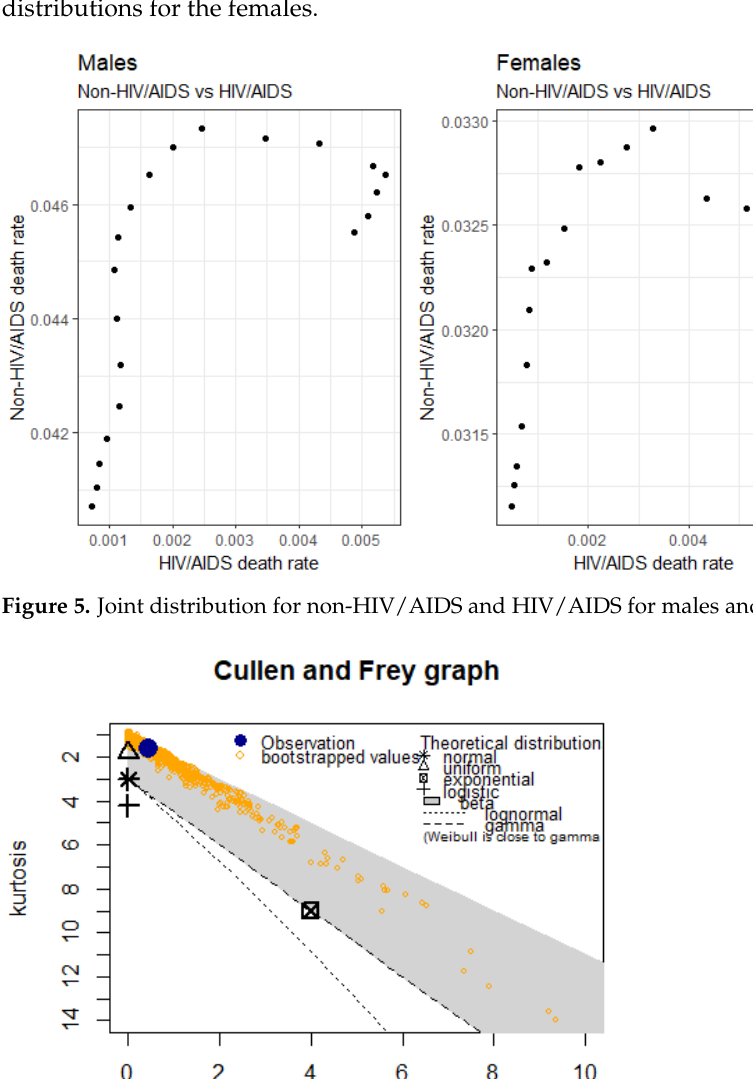
Figure 7. Estimated marginal distribution for HIV/AIDS for females. Figure 8. Estimated marginal distribution for non-HIV/AIDS for males.